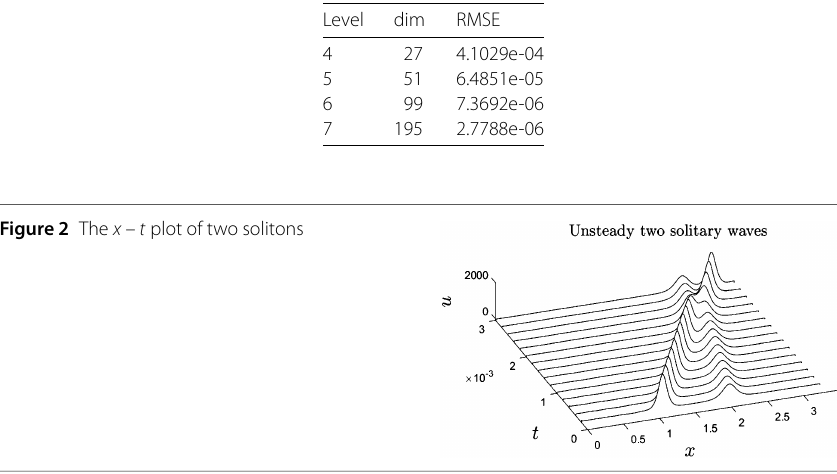
Table 1 Root mean square errors for the unsteady KdV model when p = 2 and varied wavelet level n at time t =